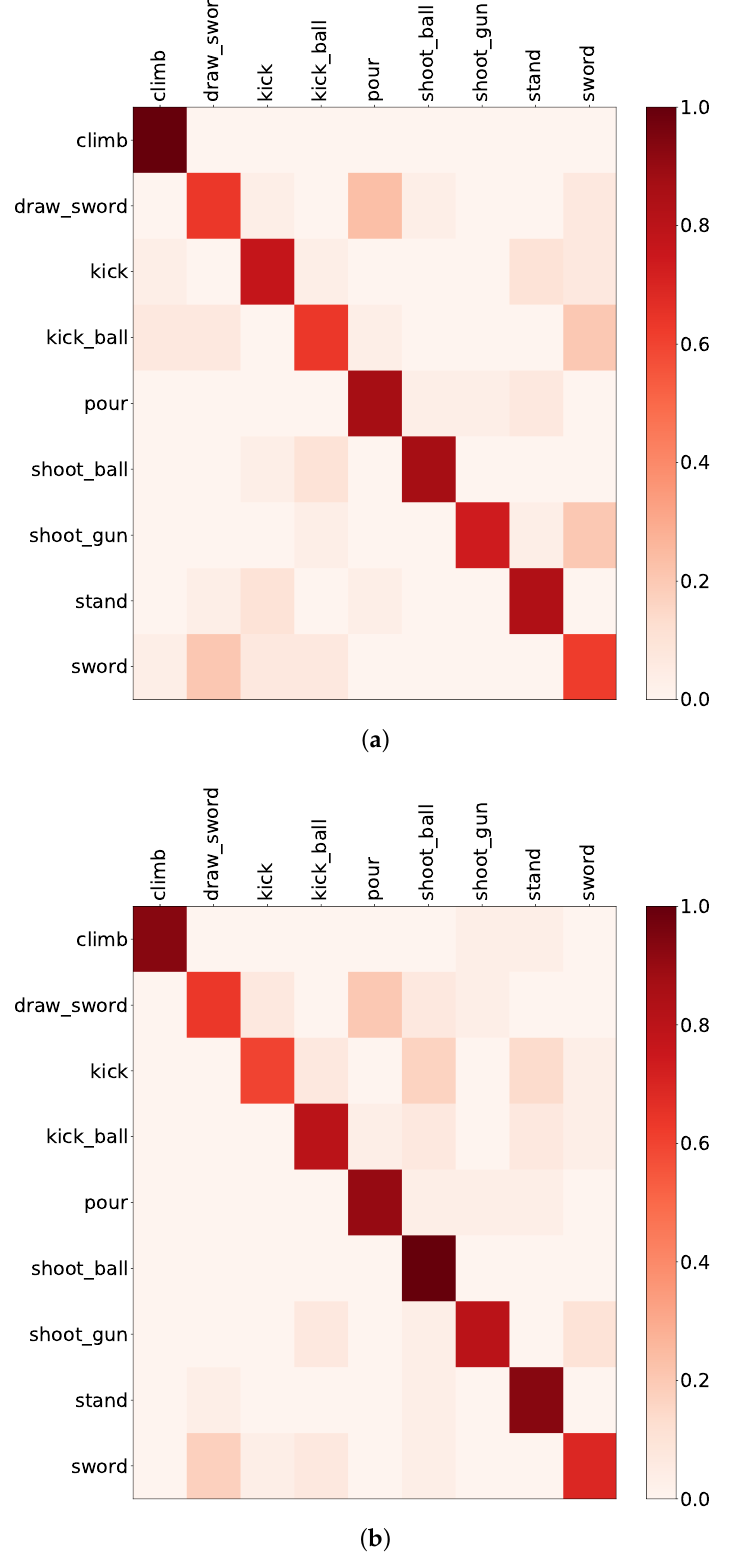
Figure 5. Confusion matrix of RABSVA-ResNet-50 on HMDB-49 datasets for 5-shot recognition. ( a ) Baseline 9-way 5-shot; ( b ) Ours 9-way